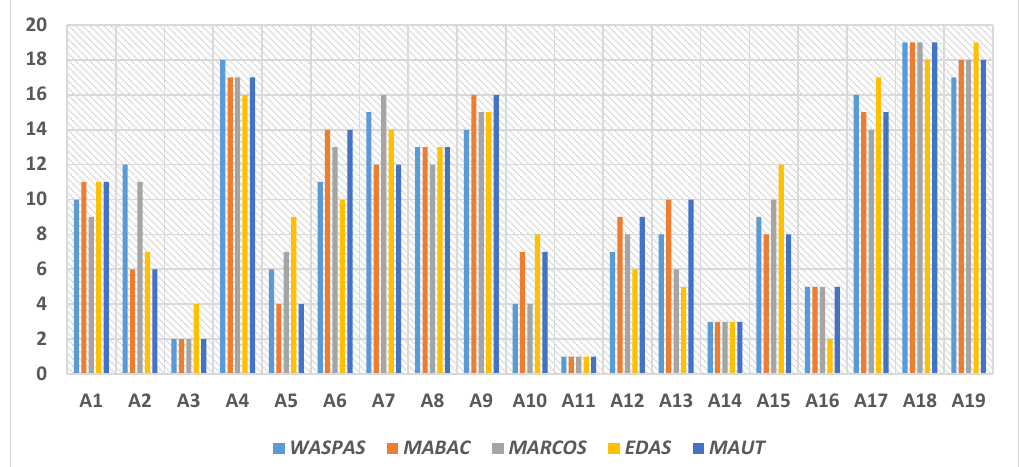
Fig. 4. Comparison between the ranking performances obtained by different